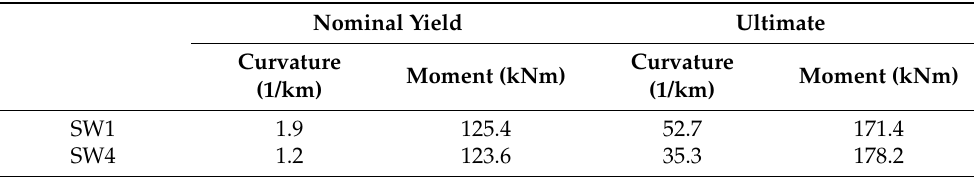
Table 4. Bi-linear moment–curvature analyses results for SW1 and